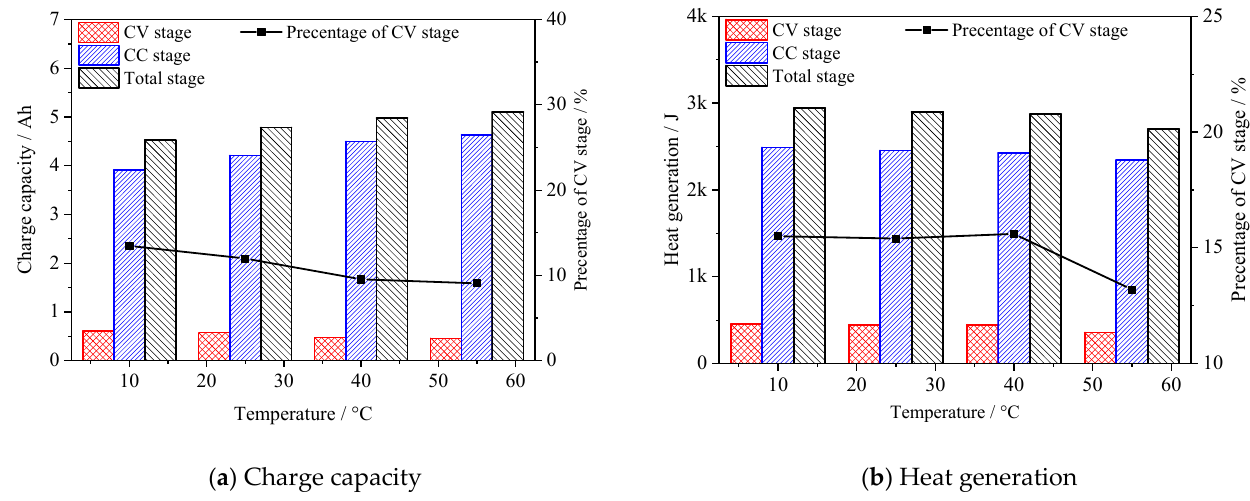
Figure 9. Effect of ambient temperature on the battery during the charge stage.